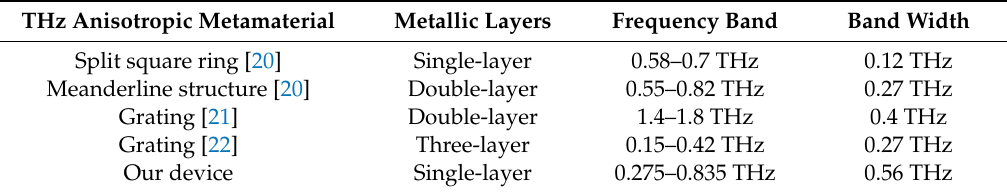
Table 1. Performance comparison of the THz